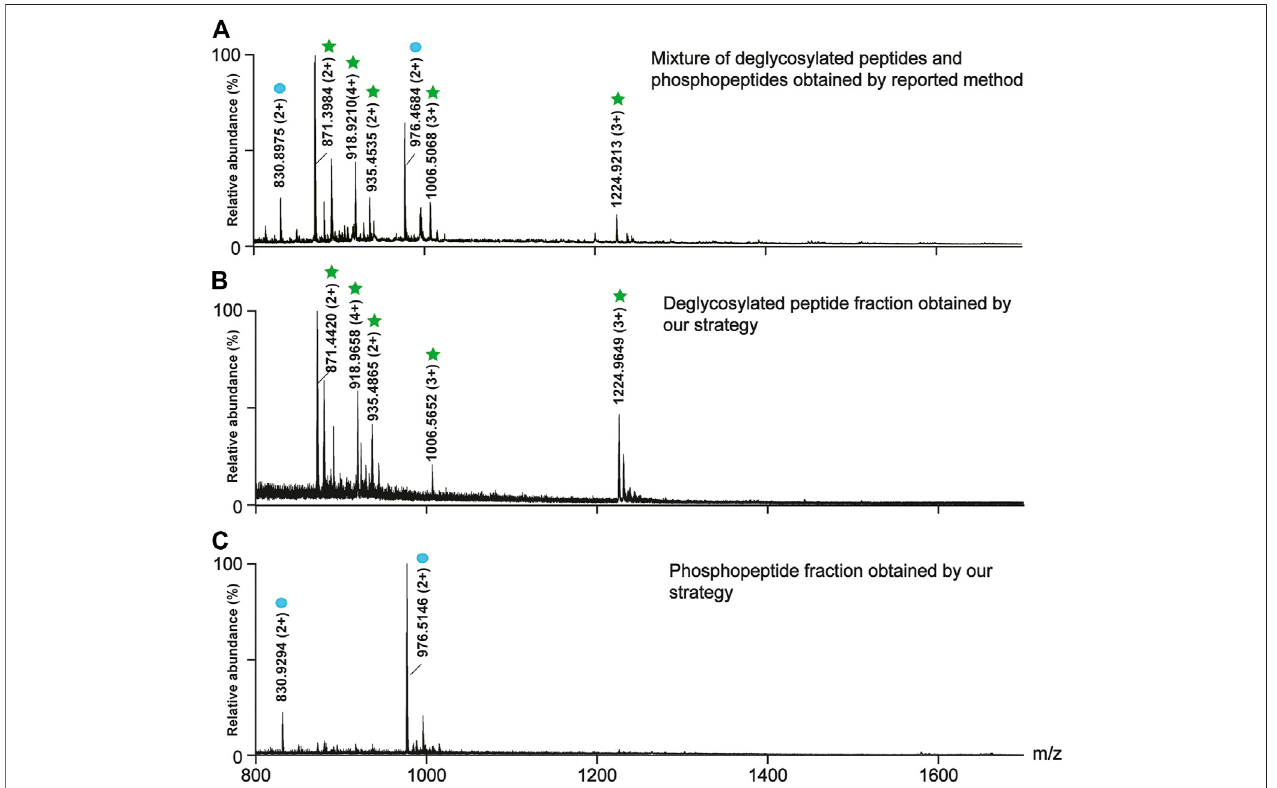
FIGURE 3 | Comparison between the reported method (A) and our strategy in the separation ef fi ciency of the deglycosylated peptides (B) and the phosphopeptides (C) . (A) The mass spectra of the mixture of the deglycosylated peptides and the phosphopeptides obtained by the reported method. The mass spectraof (B) thedeglycosylatedpeptidefractionand (C) thephosphopeptidefractionobtainedbyourstrategy.Thedeglycosylatedpeptidesandthephosphopeptides are marked with green stars and blue circles,